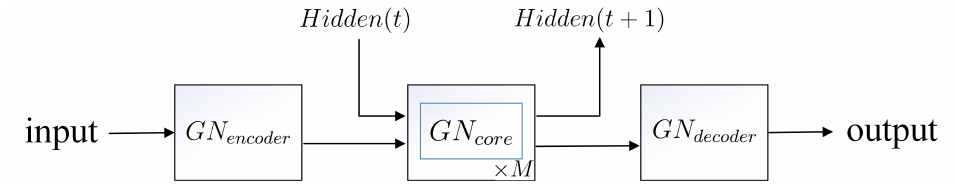
Figure 6. Encode–process–decode architecture.